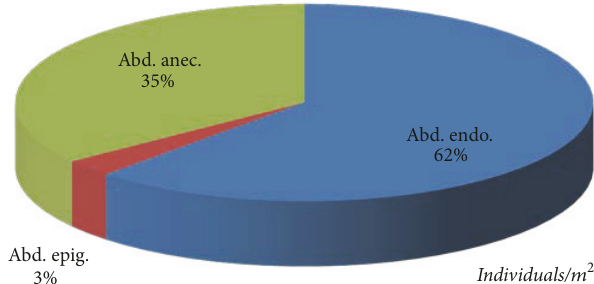
Figure 10: Earthworms’ ecologic categories: abundance average.